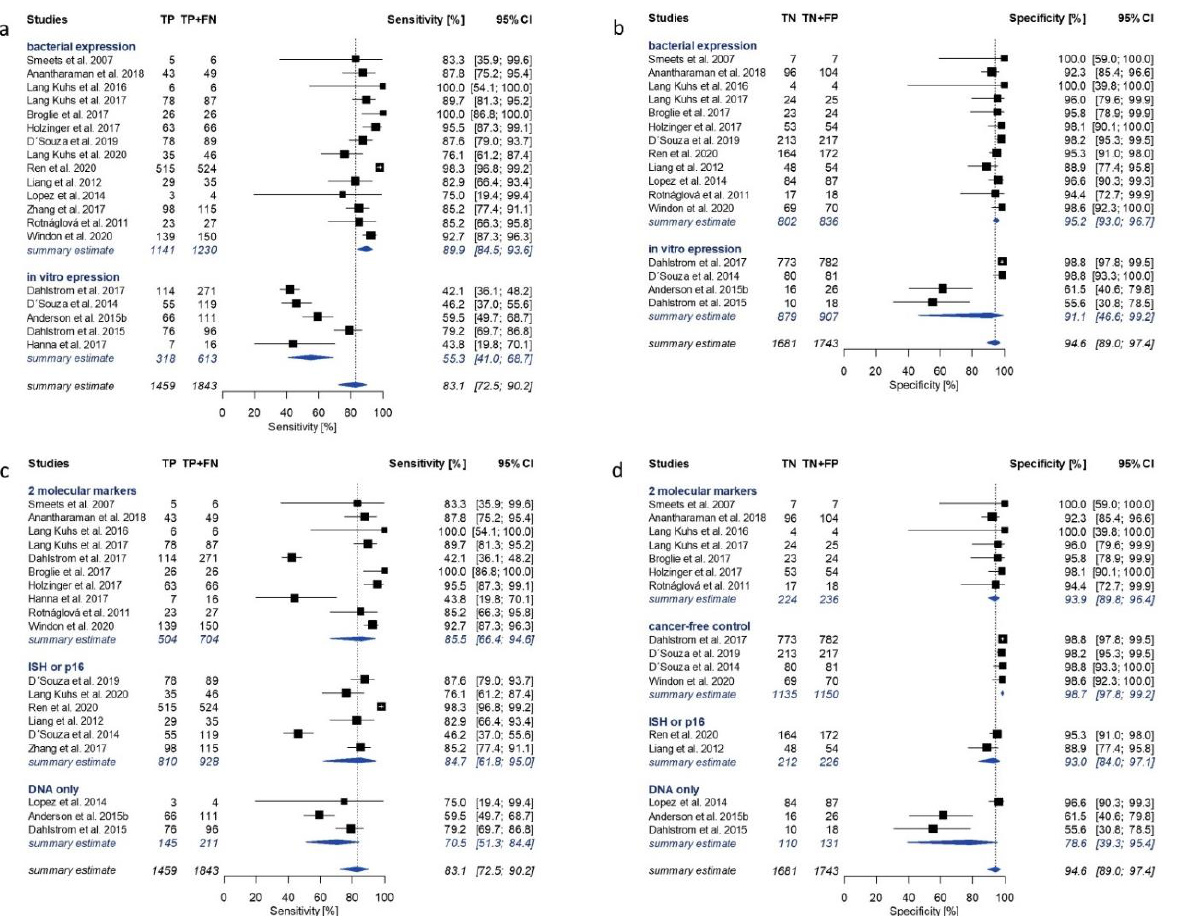
Figure 3. Forest plots of study-specific sensitivity and specificity estimates and summary estimates for HPV16 E6 serology in comparison with molecular HPV tumor status. Pooled estimates were calculated by univariate analysis of log-transformed proportions using a random effects model. Sensitivity of E6 with subgroup summary estimates (I 2 = 94.4% (92.6–95.8%)) was stratified by ( a ) protein expression system and ( c ) reference method. Specificity of E6 with subgroup summary estimates (I 2 = 85.5% (77.8–90.5%)) was stratified by ( b ) protein expression system and ( d ) reference method. TP: true positive; FN: false negative; TN: true negative; FP: false positive; CI: confidence intervals; ISH: in situ hybridization; p16: p16 immunohistochemistry; DNA only: HPV DNA PCR.